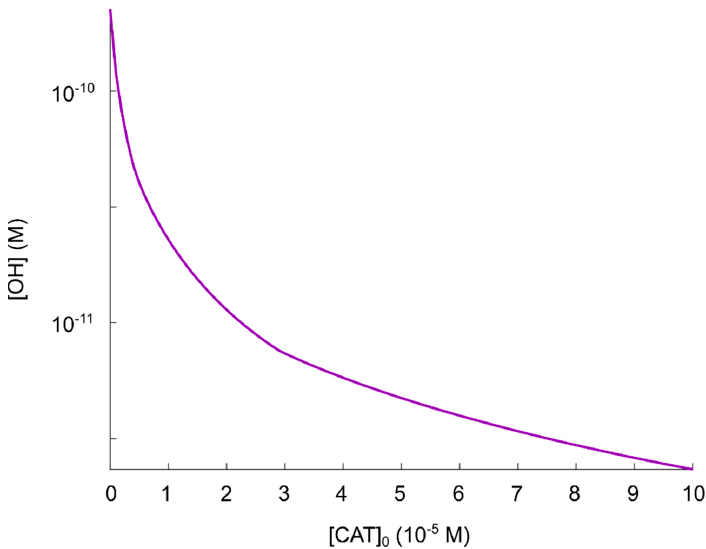
Figure 5. Maximal concentration of hydroxyl radicals as a function of catalase concentration in the regime 0 ≤ [𝐶𝐴𝑇] (cid:2868) ≤ 10 (cid:2879)(cid:2872) M . ≤ 10 − 4 regime 0 ≤ [ CAT ] 0